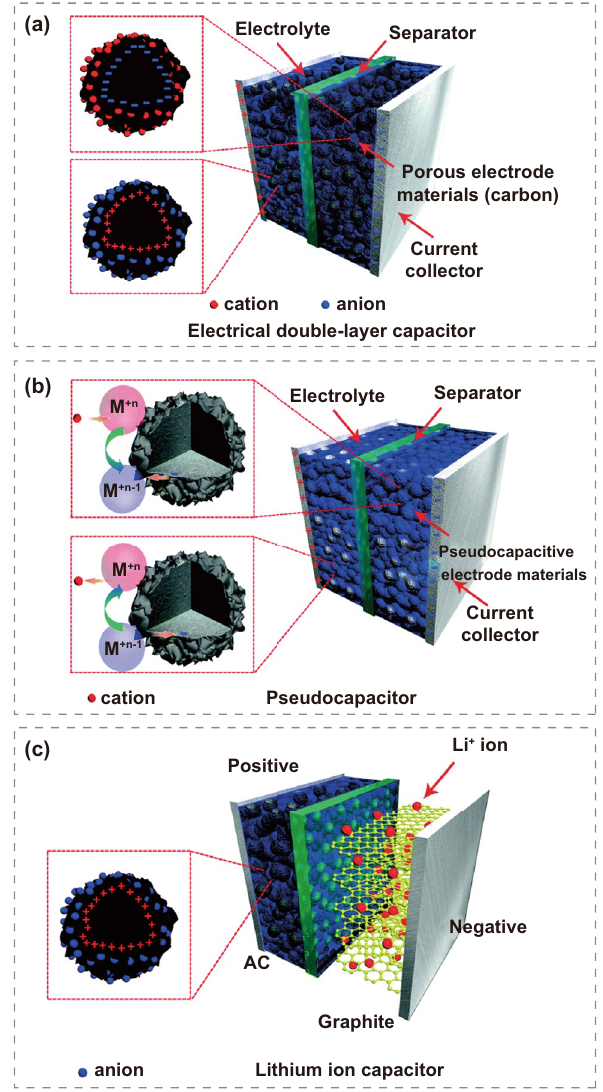
Fig. 1 Schematic diagram of a an electric double-layer capacitor, b a pseudocapacitor, c a hybrid-capacitor. Reprinted with permission from Ref. [11]. Copyright 2015 Royal Society of